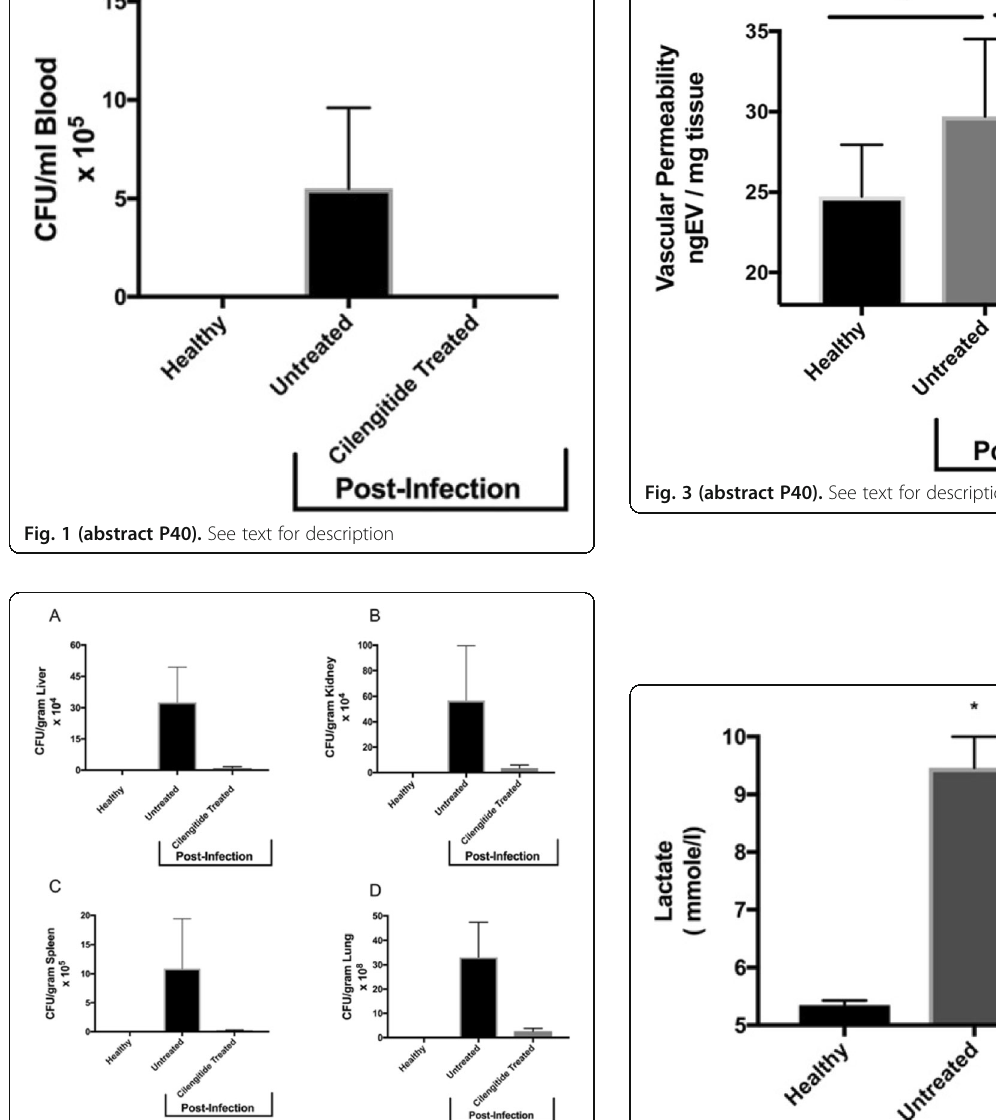
Fig. 2 (abstract P40). See text for description